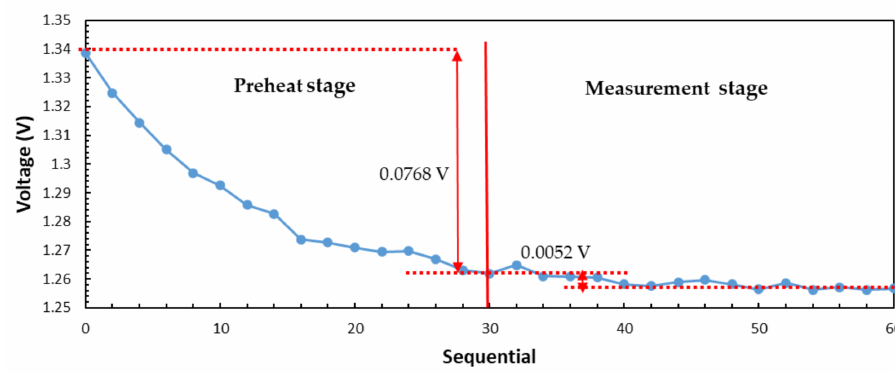
Figure 12. Actual water temperature test result of interferometric microwave radiometer.